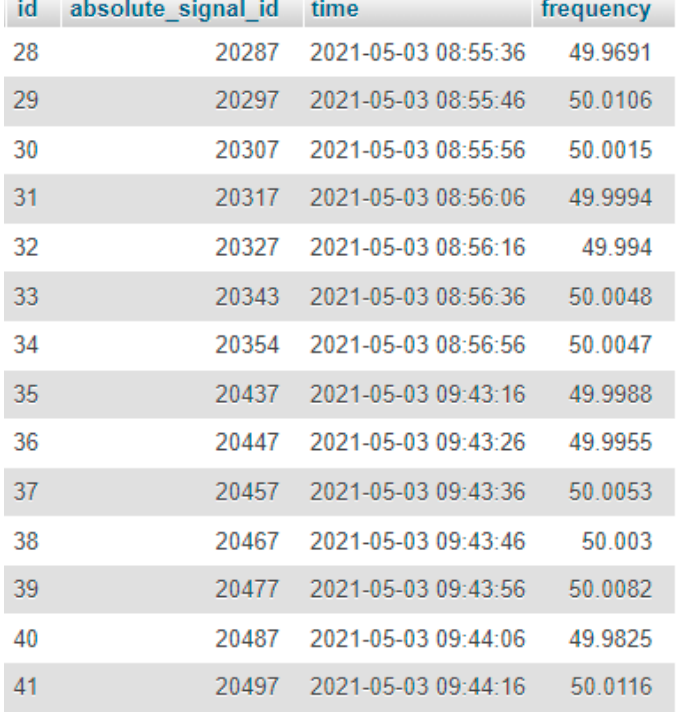
enumerate the rows of the monthly table. “Absolute signal id”: foreign key from the global signal list table. “Time”: date in which the measurement was taken. Format: signal list table. “Time”: date in which the measurement was taken. Format: YYYY-MM- DD HH:MM:SS. “Frequency”: calculated frequency value in Hz. Following these critera,